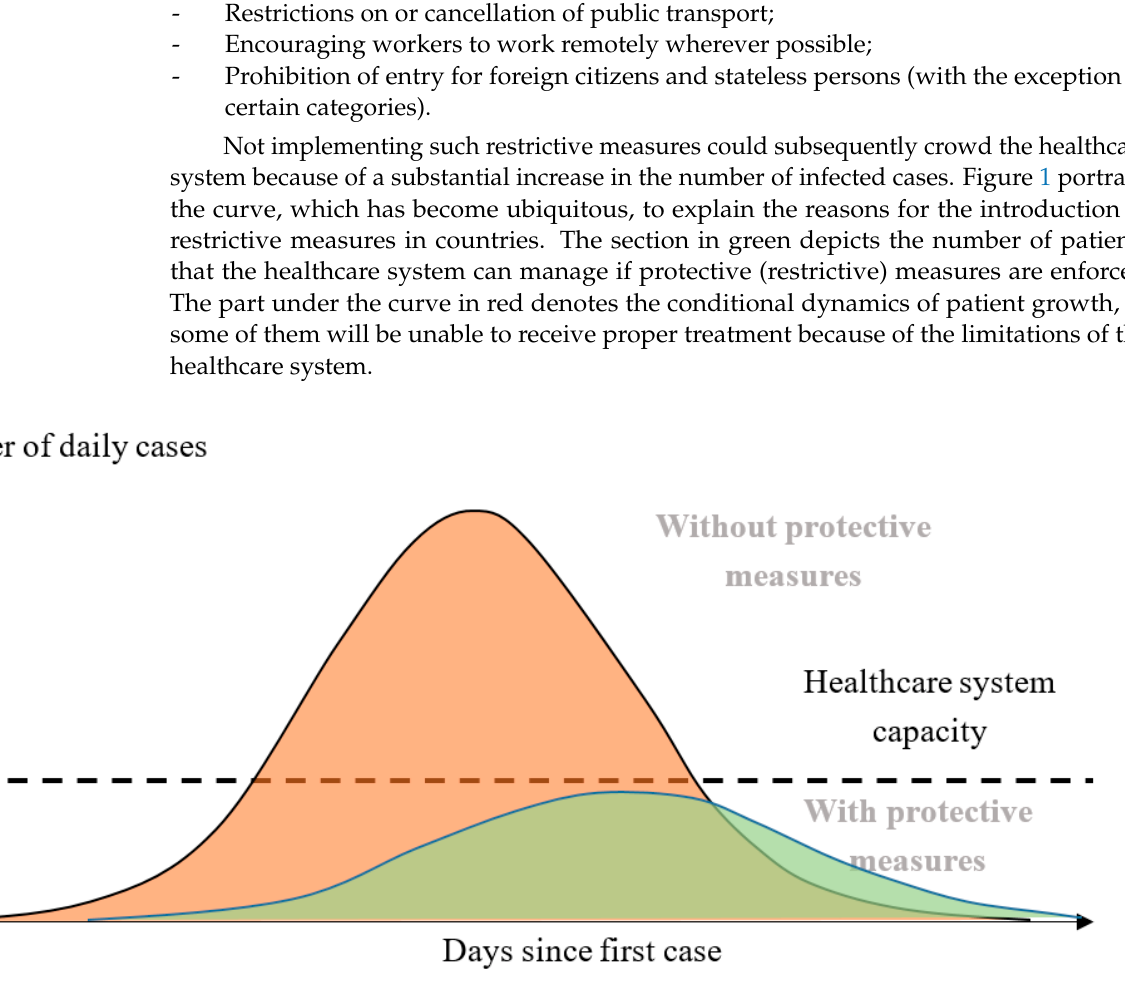
Figure 1. Number of patients and healthcare system capacity.